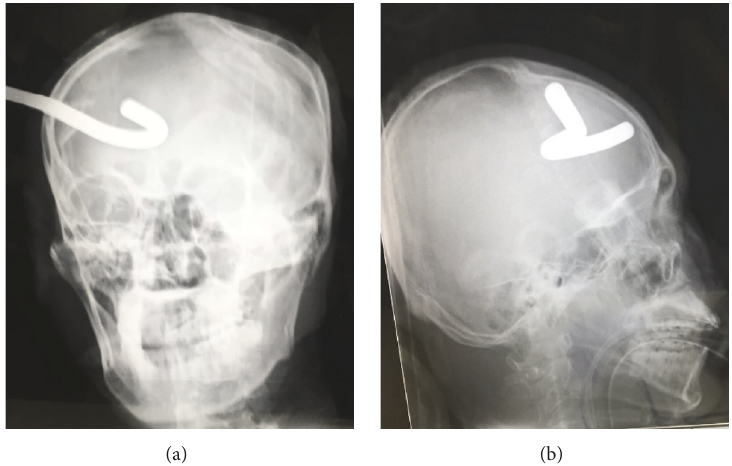
Figure 2: (a) Plain X-ray of the skull (A-P view) showing a hook-shaped metal bar on the right side. (b) Plain X-ray of the skull (R-L view) showing the metal bar in the frontal